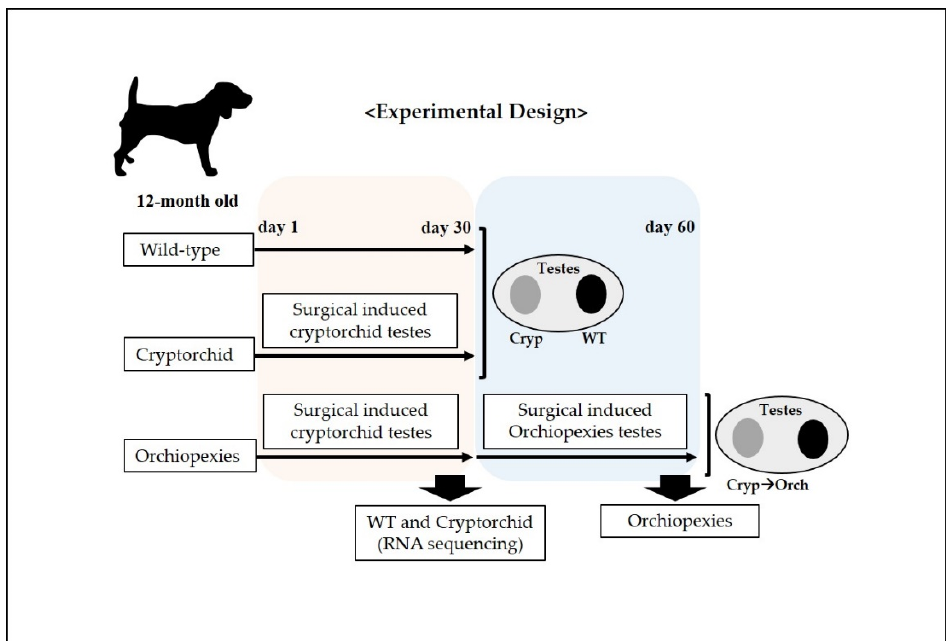
Figure 1. Schematic representation of the experimental design for the surgically induced cryptorchid and orchiopexies dog models. At day 1, cryptorchidism was surgically induced in one testicle in each dog (6 dogs), and the unoperated testicle was considered to be the wild type; cryptorchid samples were collected. In addition, 30 days after the surgical induction of cryptorchidism, surgery was performed to induce orchiopexies in 3 dogs; 30 days post-surgical induction of orchiopexies, testes samples were harvested.